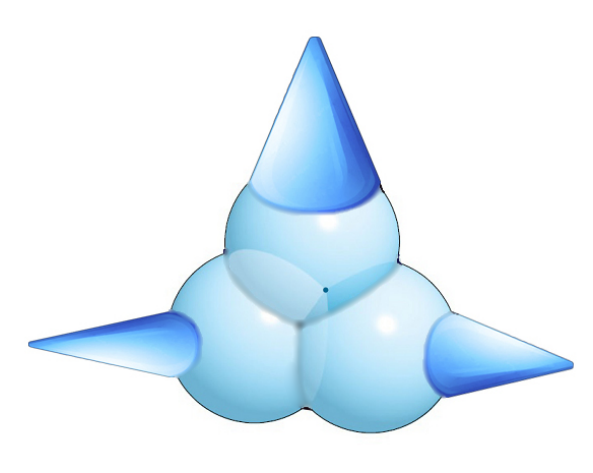
Fig. 1: Domain generating exactly three ground states